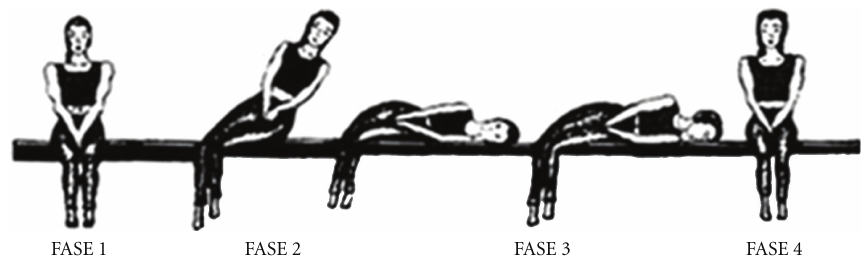
Figure 2: Modified Gufoni’s manoeuvre for the geotropic form of right